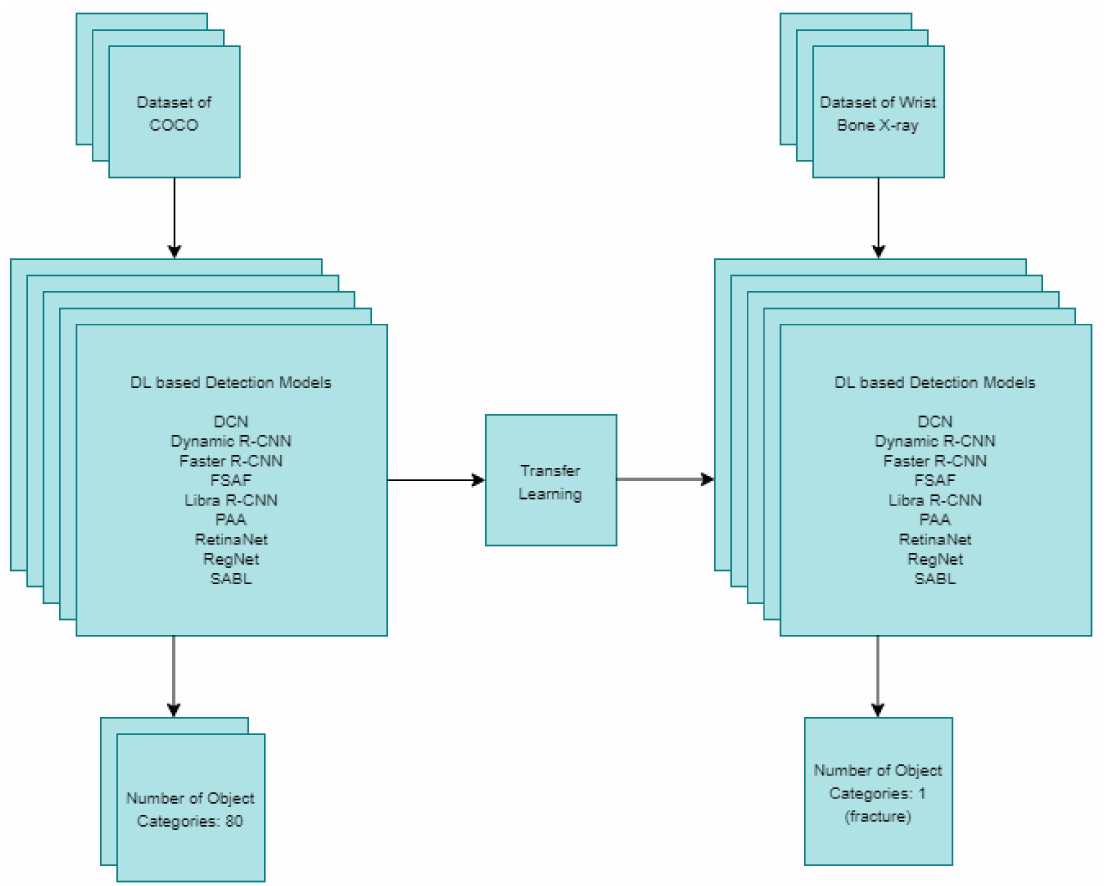
Figure 2. Deep-learning based detection models using transfer